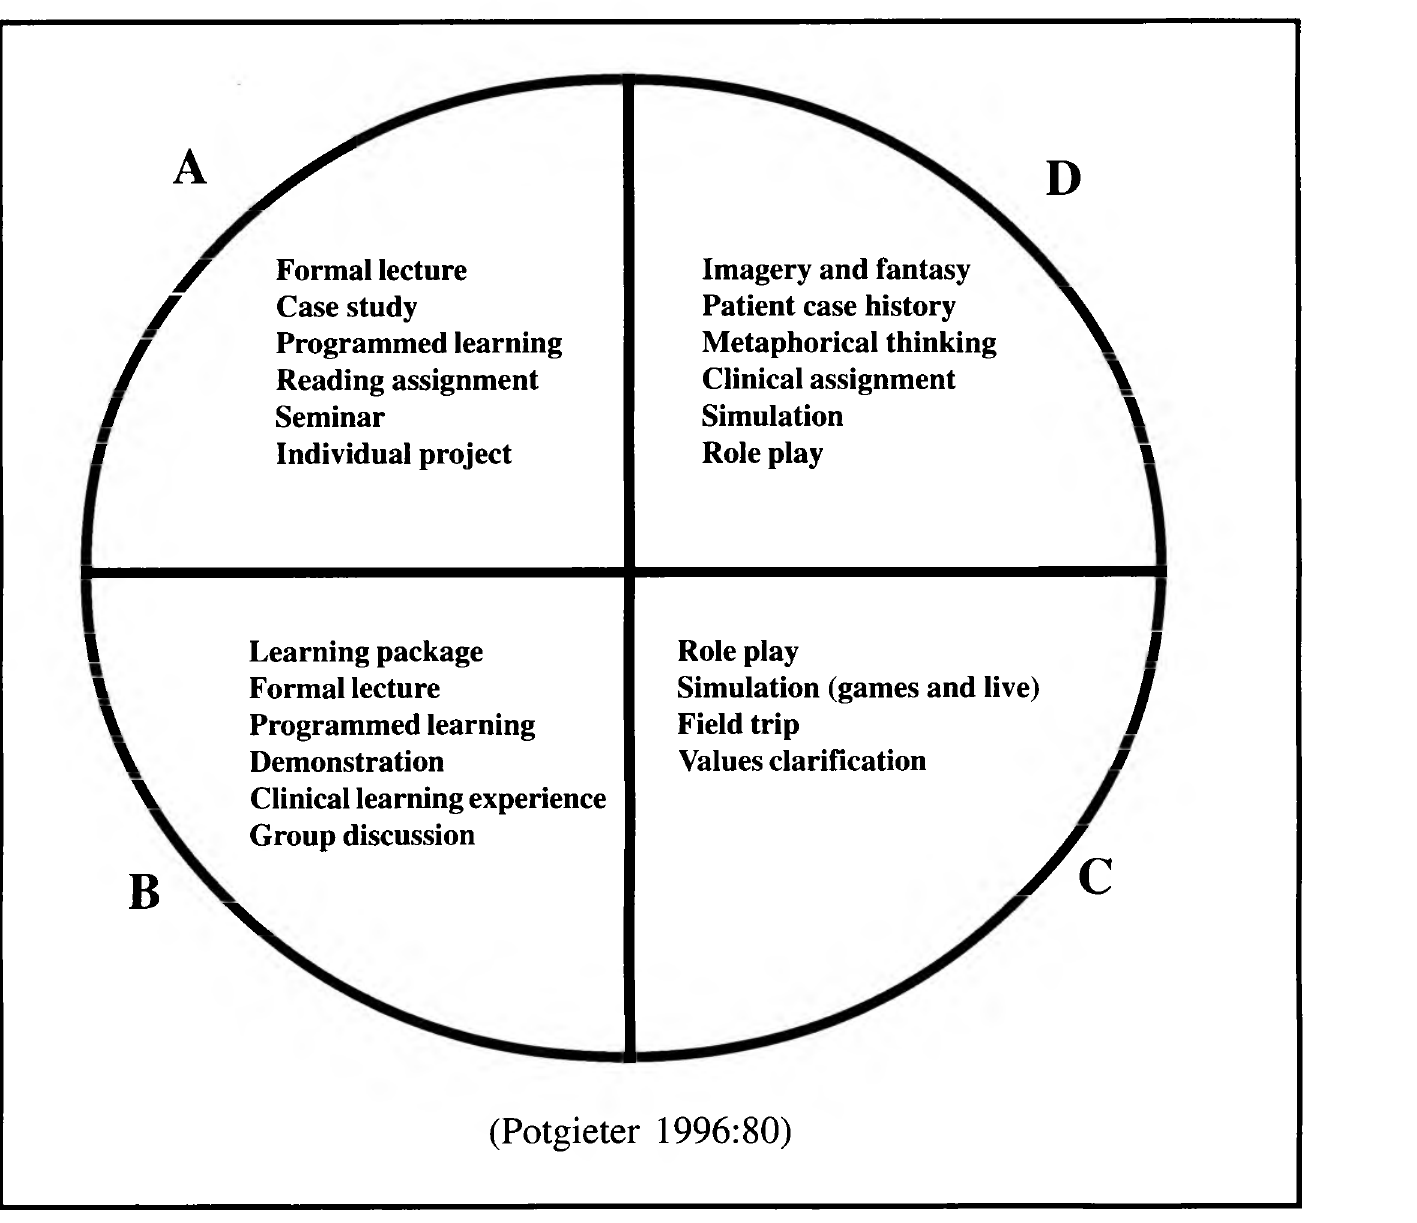
Figure 3 : Teaching strategies for w hole brain teaching and